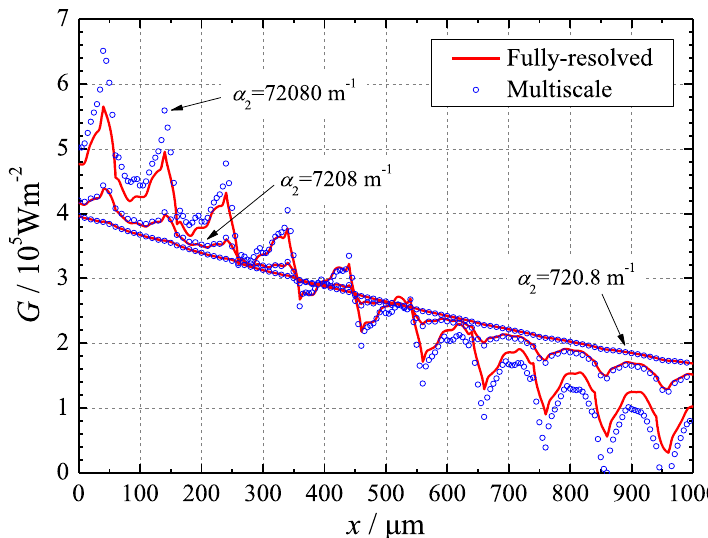
Fig. 8 The incident radiation profiles of the fully‑resolved simulations and the multiscal simulations on line y 0.05 mm with different absorption coefficients α =